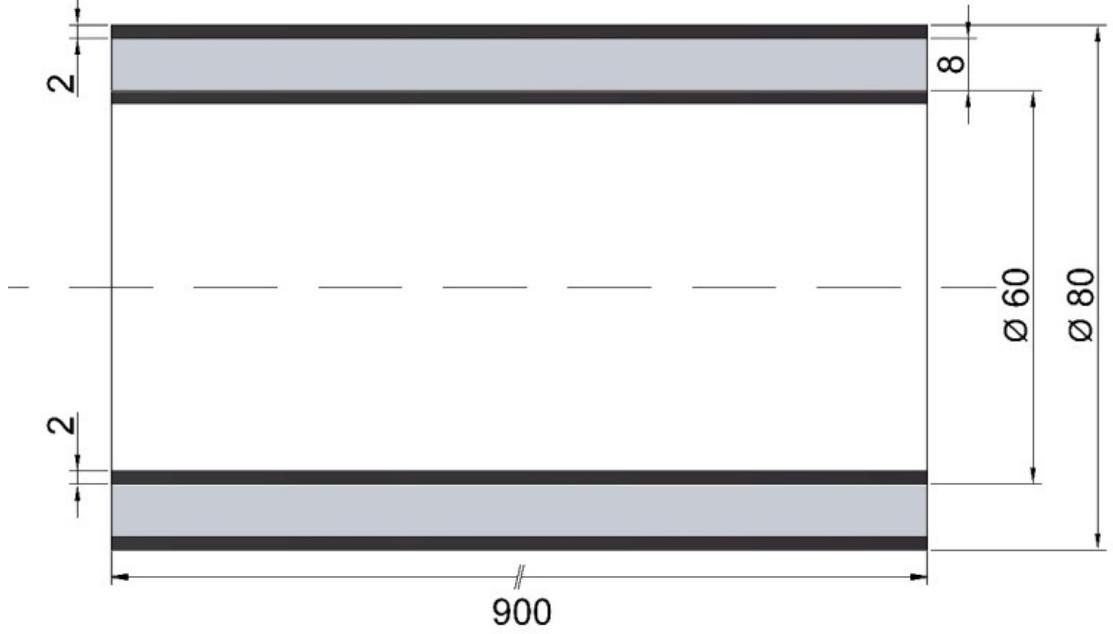
Figure 1. Hybrid tubular element: outer tube, inner tube, and core filled with different nonmetallic materials.